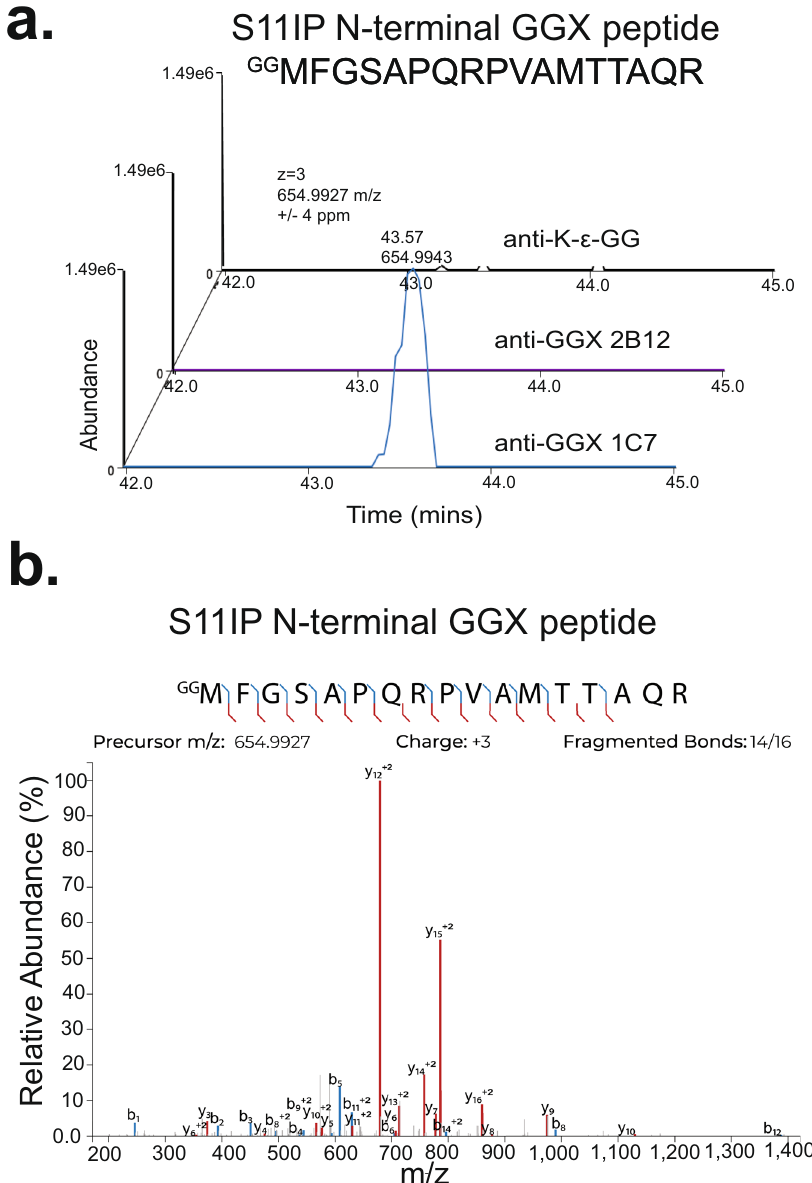
Fig. 4 MS identi fi cation of S11IP N-terminal Ub peptide. a Extracted ion chromatograms (±4 ppm) for N-terminal GGX peptide GG MFGSAPQRPVAMTTAQR in anti-K- ε -GG, anti-GGX 2B12, and anti-GGX 1C7 immunoaf fi nity enrichment MS experiments. b MS/MS spectrum identi fi cation of triply charged 654.9938 m/z N-terminal GGX modi fi ed peptide GG MFGSAPQRPVAMTTAQR. Detected b- and y- ions highlighted in blue and red,